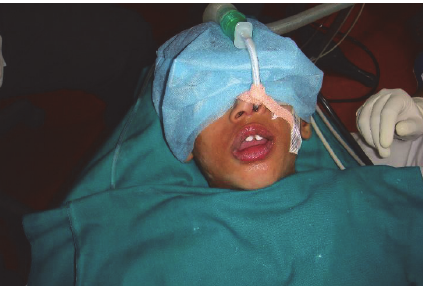
Figure 1: Dental treatment under general anesthesia (Case 1 ).